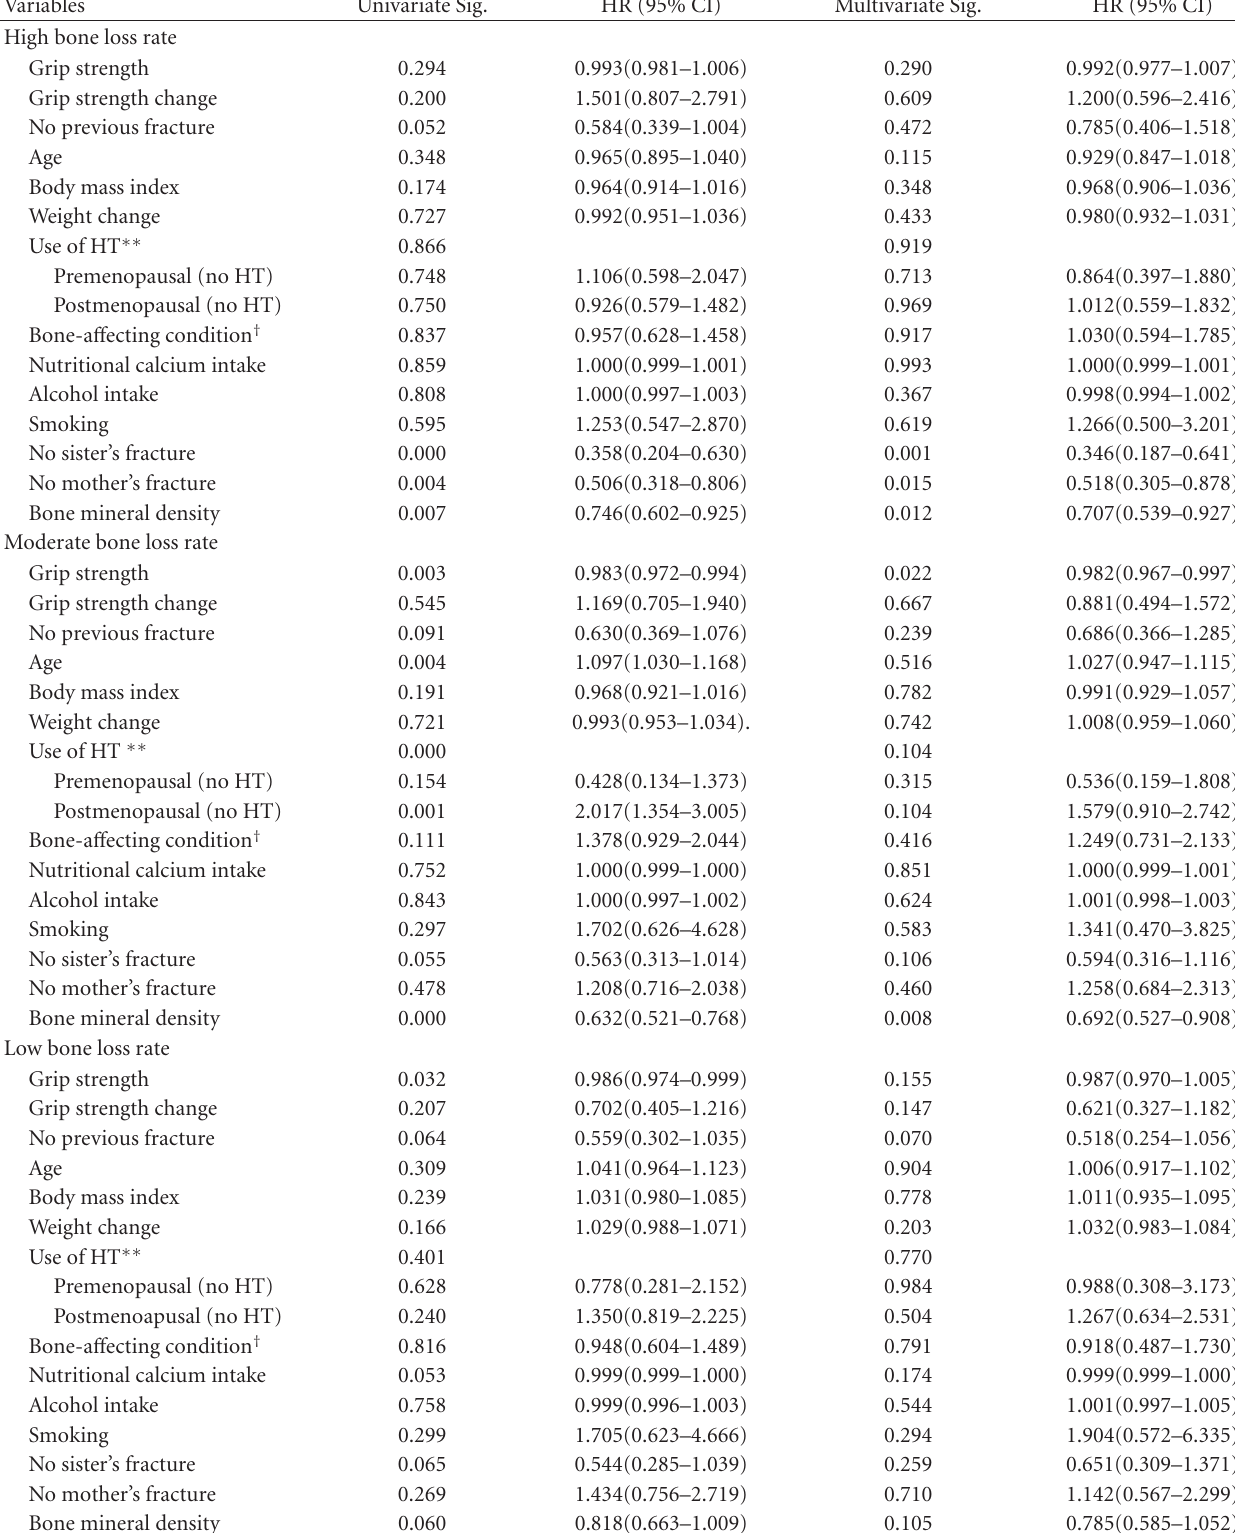
Table 2: Predictors of 15-year fracture free-survival according to bone loss rate tertiles. Uni- and multi-variate Cox proportional hazards models ∗ ( n =